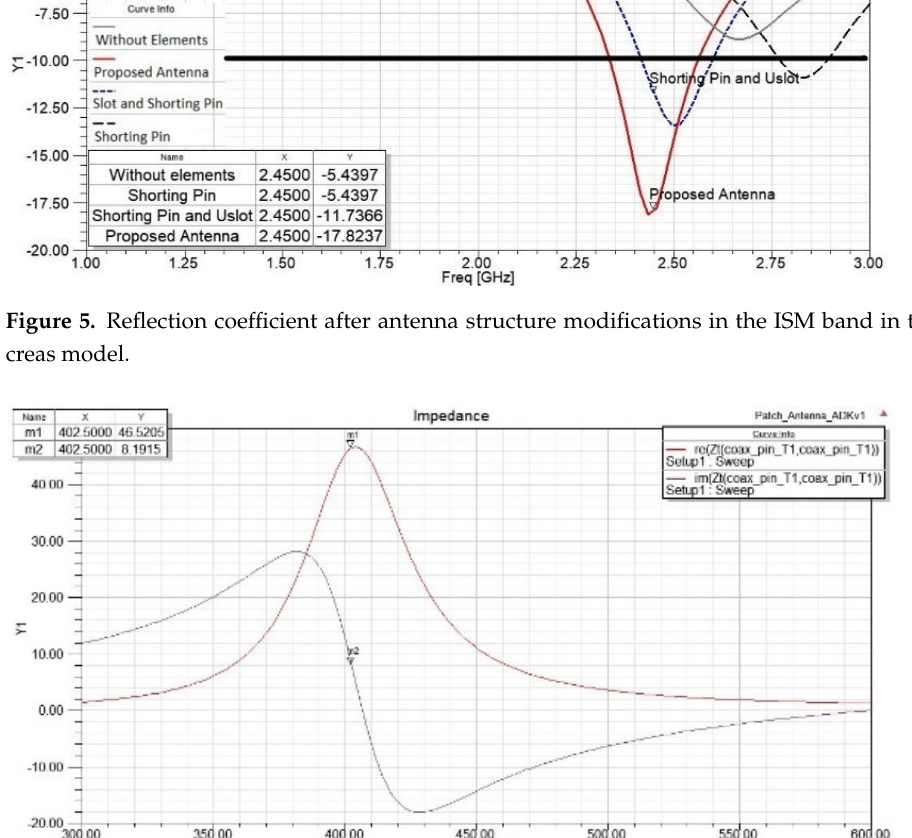
Figure 6. Calculated impedance of the antenna in the MedRadio band in the pancreas model.